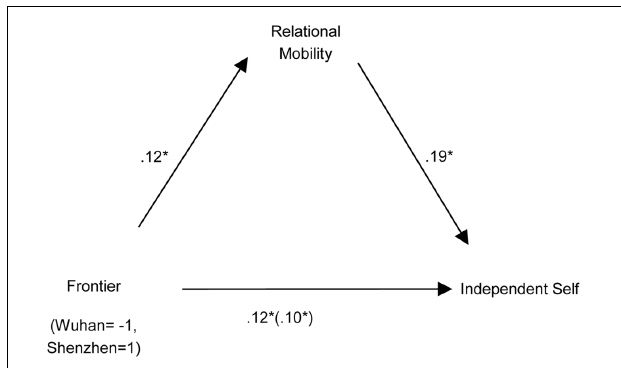
FIGURE 1 | Unstandardized betas from a path analysis examining the role that relational mobility plays in mediating the effects of Frontier and independent self. ∗ p <